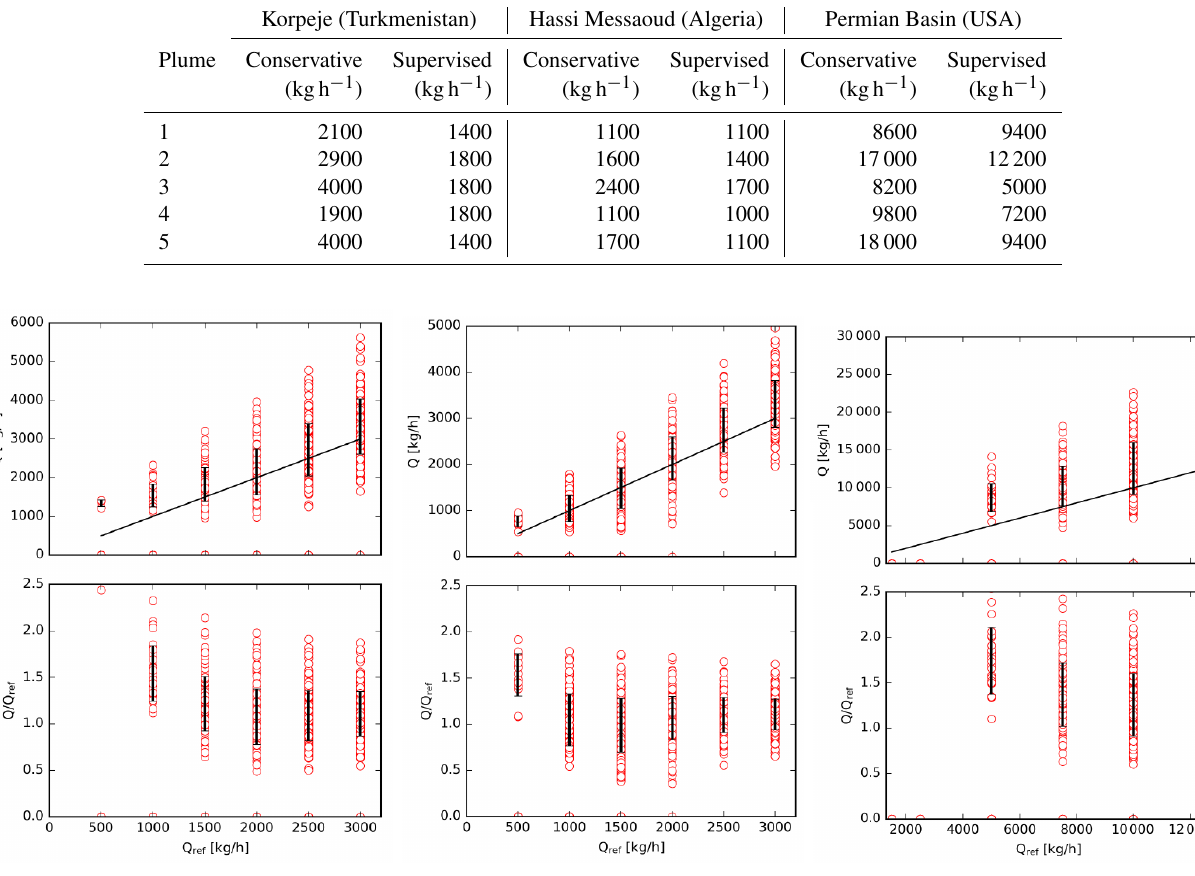
Table 1. Methane flux rate detection limit for the selected sites at Korpeje (Turkmenistan) (see Fig. 2a), Hassi Messaoud (Algeria) (see Fig. 2b) and the Permian Basin (USA) (see Fig. 2c) under two different detection masking criteria (conservative and supervised) detailed in Section 4.